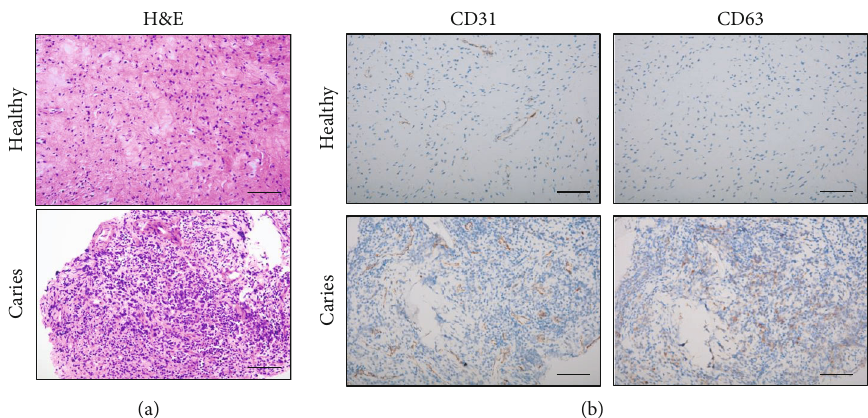
Figure 1: Histological study of the in fl ammatory dental pulp. (a) H&E stain of dental pulp tissue of healthy and deep caries teeth ( n = 3 ) (scale bar, 50 μ m). (b) Expression of CD63 (exosome marker) and CD31 (vascular endothelial markers) were detected by IHC assay in dental pulp tissue from healthy and deep caries teeth ( n = 3 ) (scale bar, 50 μ m). The blood vessel density and exosome expression increased in deep caries dental